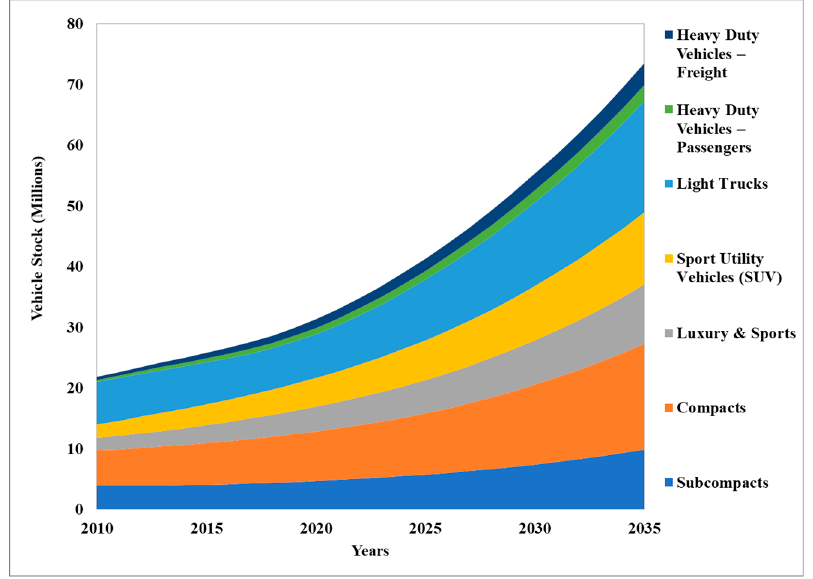
Figure 2. Evolution of the Mexican vehicle fleet in the BLS.